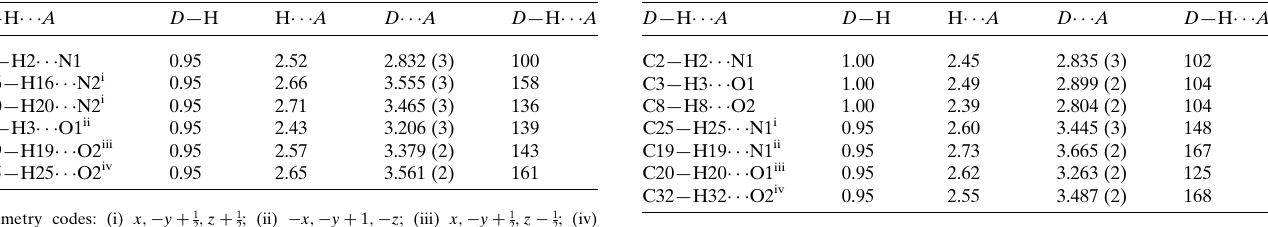
Table 2 Hydrogen-bond geometry (A˚ , (cid:3) ) for (2).